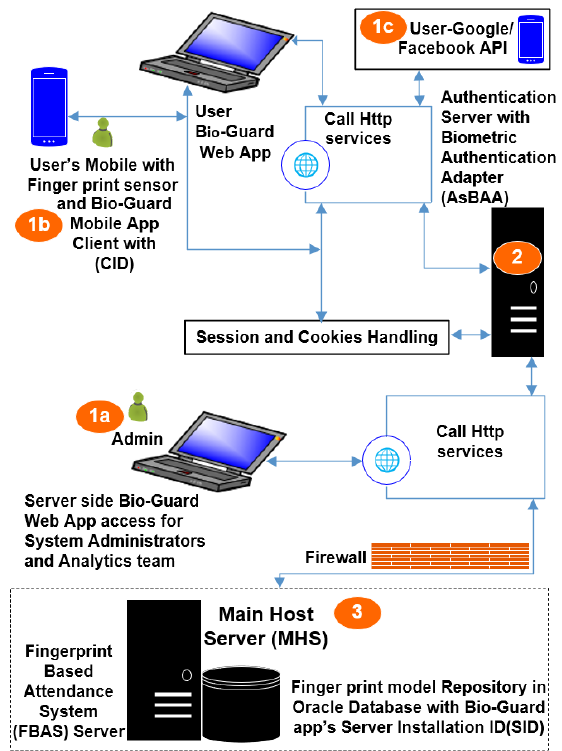
Figure 1. An overview of the architectural diagram showing how biometric authentication data flows after installing the Bio-Guard App on a registered mobile device and Oracle biometric authentication server. The numbers 1a, 1b, 1c, 2 and 3, represent the multi-directional, multi-user sequential points. The processes are described in Figures 2a, 2b, 3a, 3b, 4a, and 4b.